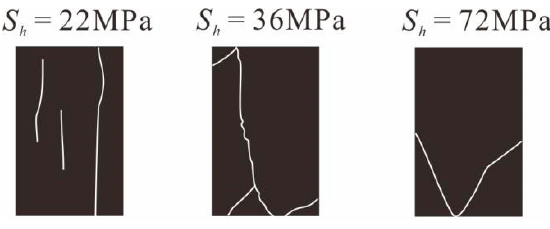
Figure 17. Influence of minimum horizontal stress ( S h ) on failure mode.